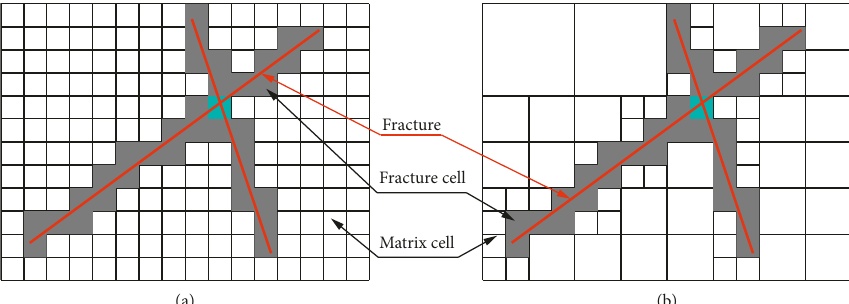
Figure 1: Sketch of fracture cell and matrix cell concept in the EFC approach using the uniform Cartesian mesh obtained from the global refinement technique (a) and nonuniform Cartesian mesh based on the local refinement technique with the hanging nodes (b).